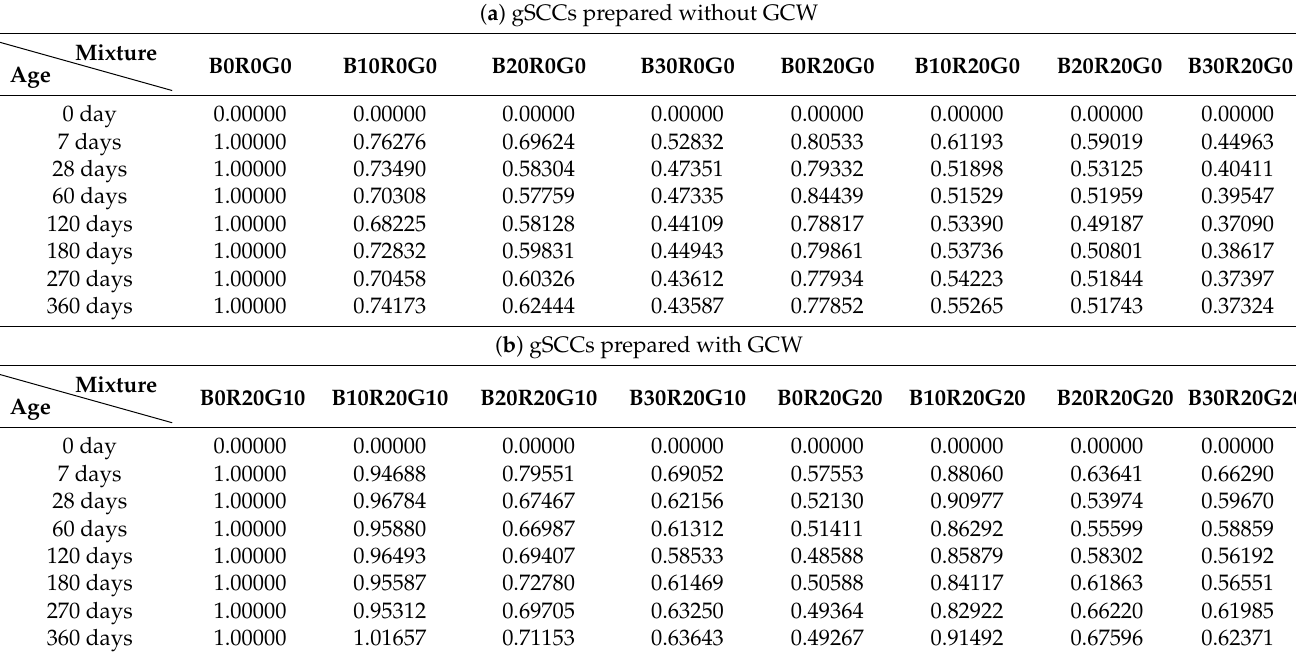
Table 5. Normalized CSD compared to the control SCC